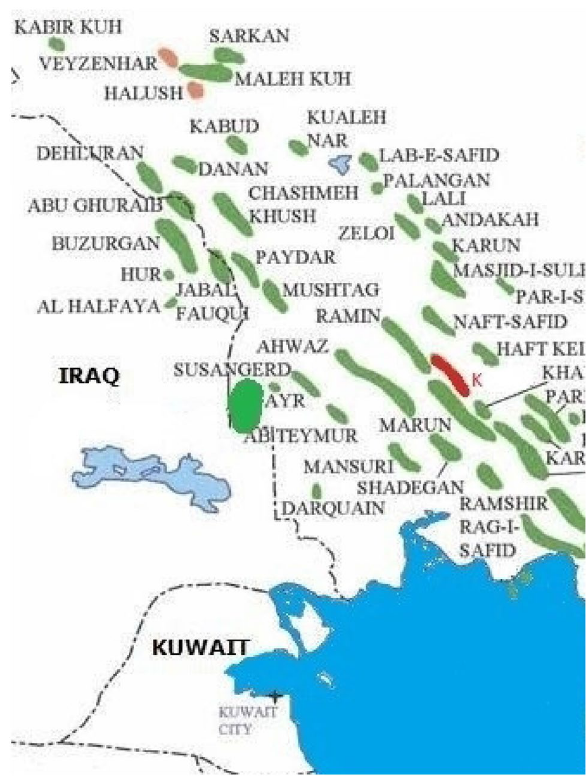
Fig. 1 The location of Kupal oilfield in the Middle